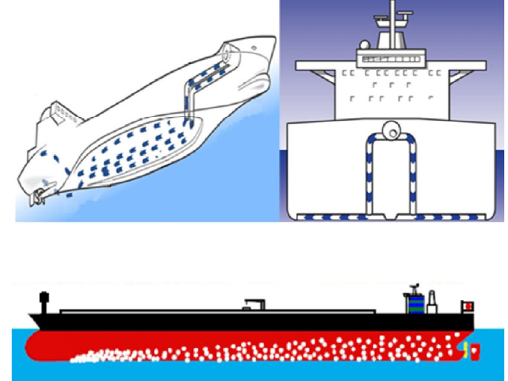
Fig. 13 Principle of Air Cavity System,